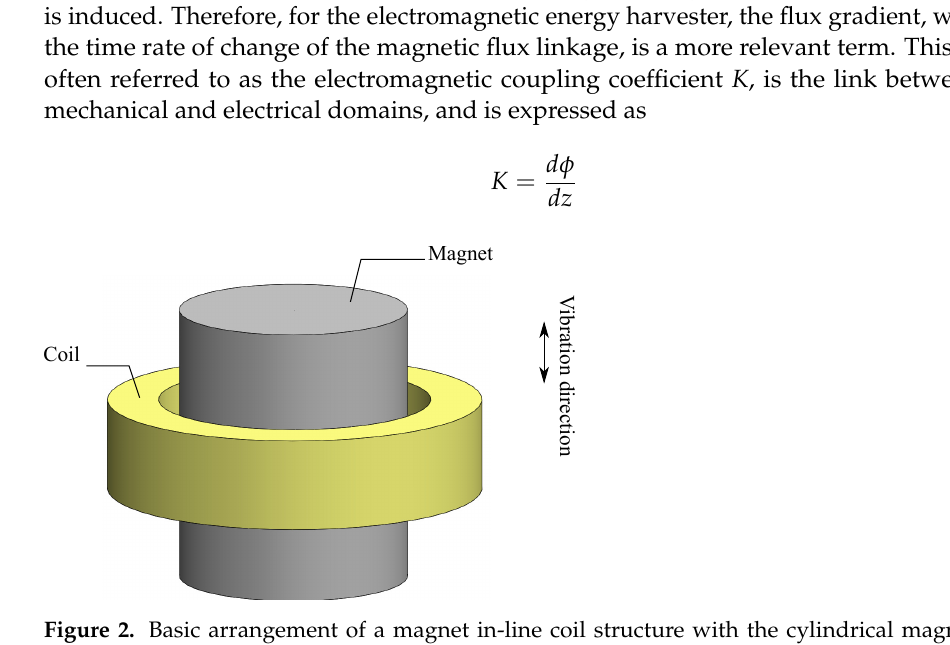
Figure 2. Basic arrangement of a magnet in-line coil structure with the cylindrical magnet and hollowed, cylindrical